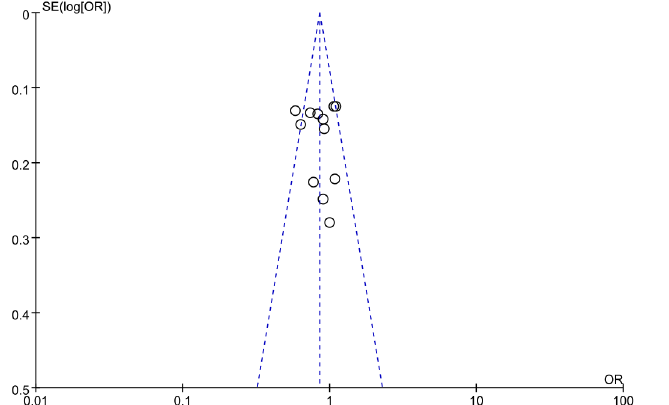
Fig 8. Funnel plot to detect publication bias in data on ADIPOR1 SNP rs1342387(G/A) according to a dominant model.